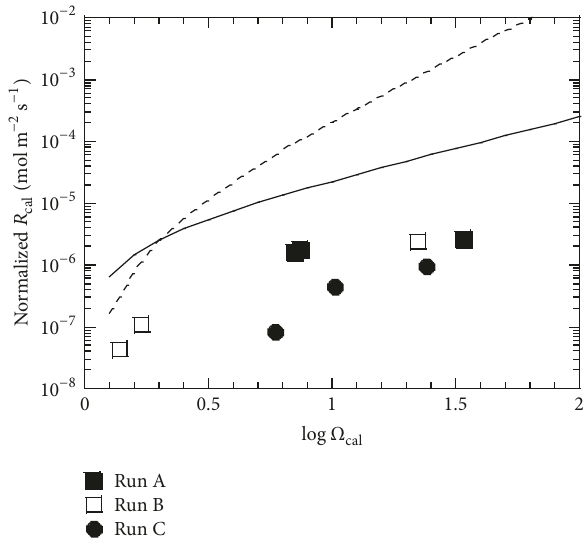
Figure 6: Comparison of 𝑅